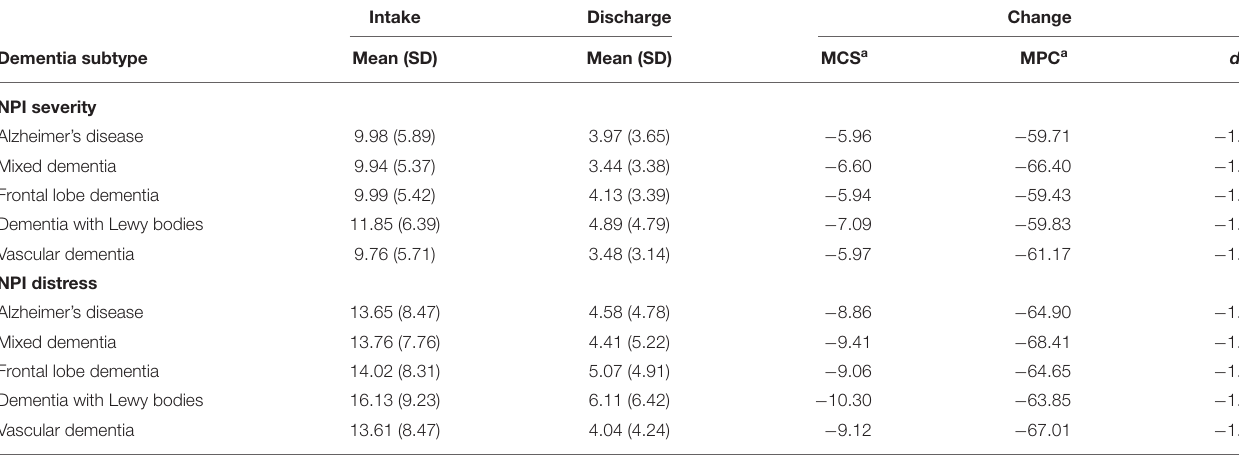
TABLE 6 | Clinical impact of DSA programs on NPI total severity scores and distress scores by major dementia subtype. Intake Discharge Change Dementia subtype Mean (SD) Mean (SD) MCS a MPC a d a